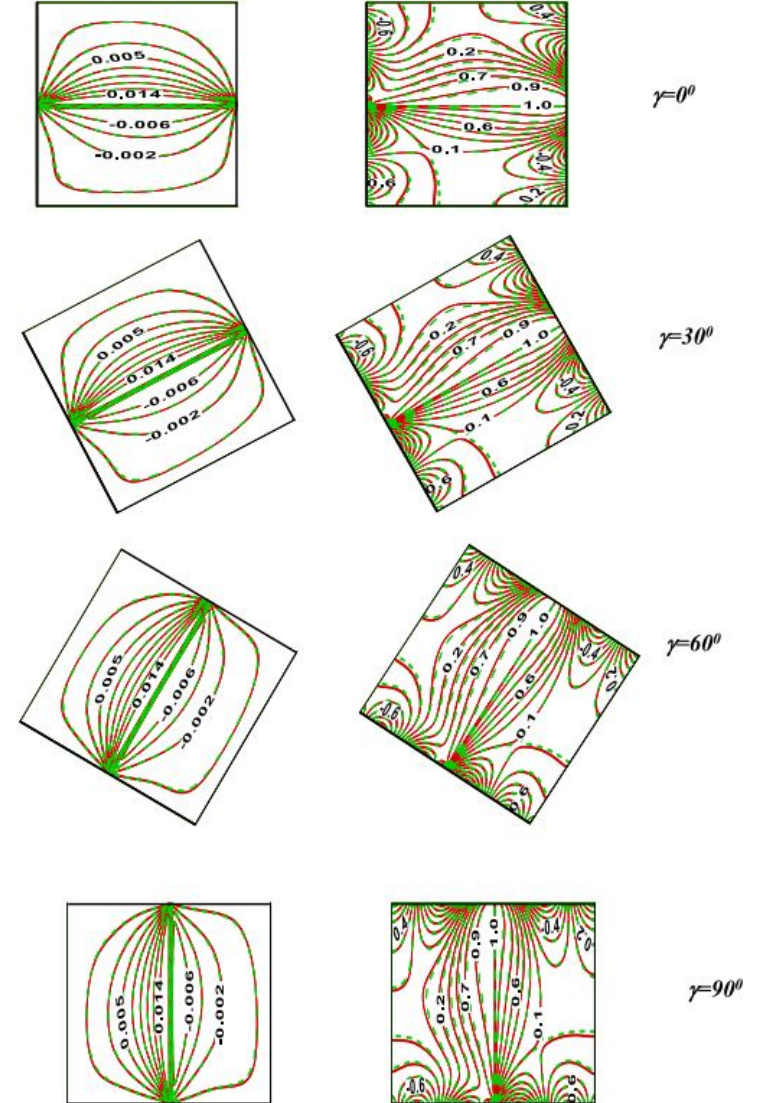
Figure 10. Effect of the inclined cavity on heat transfer [104]. The inclination angle reveals a vibrant factor that significantly impacts the cavity’s flow fields and temperature lines. The streamlines of the fluid inside the cavity are nearly stationary for the average angle of inclination ( 0 (cid:2868) ≤ 𝜃 ≤ 60 (cid:2868) ). At a high Ri, the impact of the inclination angle is generally observed in the temperature distribution and the fluid flow. In conclusion, the angle of inclination of the cavity and the periodic thermal bound- ary conditions are both effective means of controlling the parameters that govern the movement of heat and fluid inside the cavity. 5. Future Recommendations Several recommendations for future research efforts are made considering the litera- ture review. According to the study, the Tiwari and Das nanofluid mathematical model